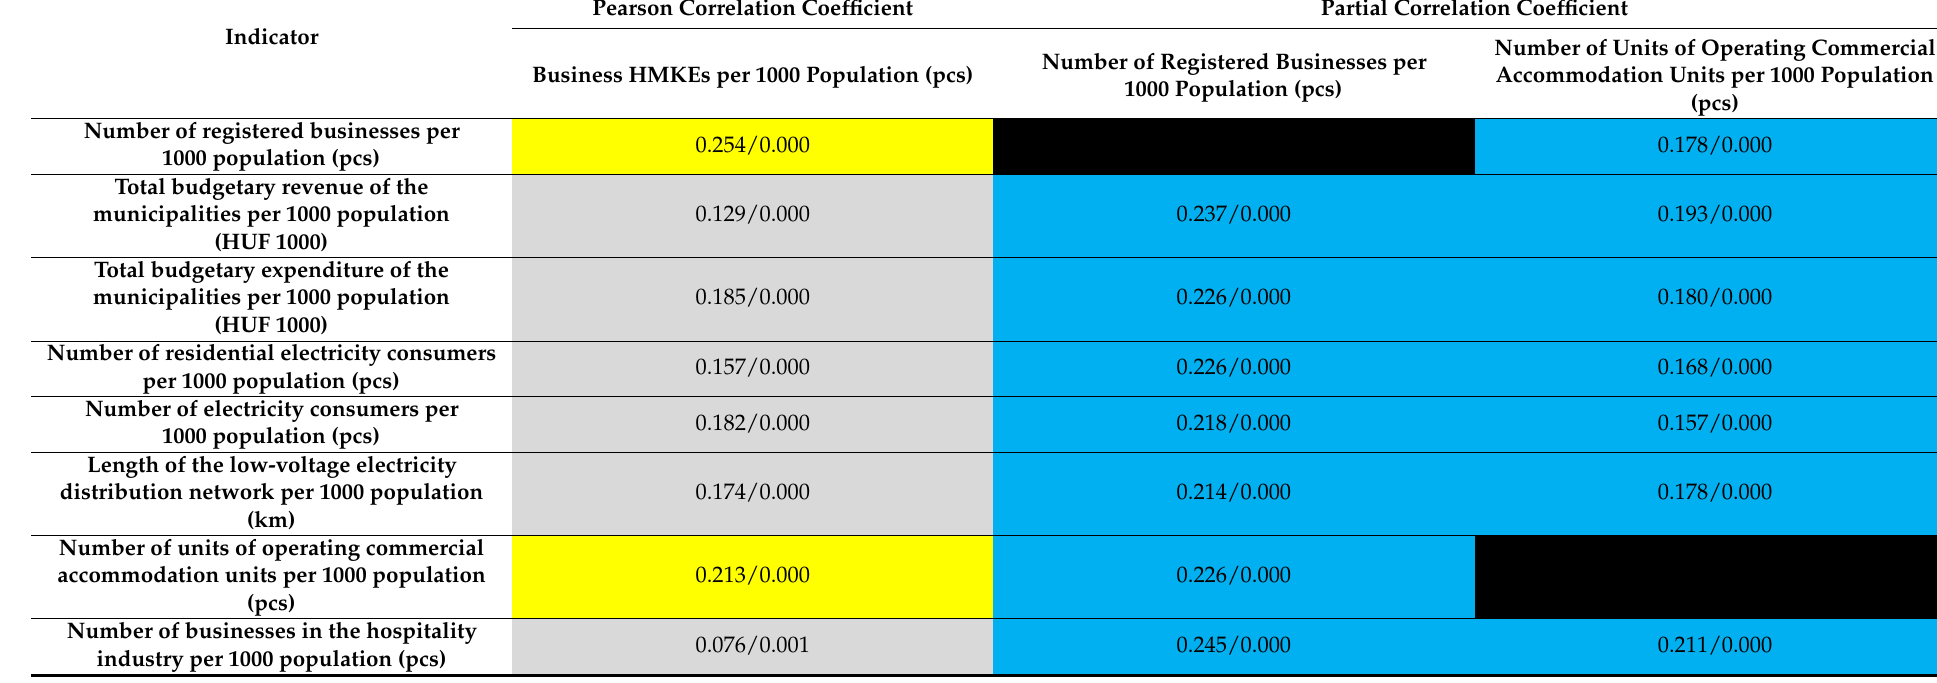
Table A9. The strengths of the relationships between the quantity of the business HMKEs per 1000 population and the settlement indicators 1 ( 1 Pearson correlation coefficient/ p -value; if p < 0.05, then there is a significant verified relationship between the two variables) (In the case of the Pearson correlation coefficients in the table grey background indicates weak correlations and yellow means weak moderate ones. In the case of the partial correlation the blue background signals partial explanation (the controlled variable explains the relationship between variables i and j only partially), while the black one shows irrelevant